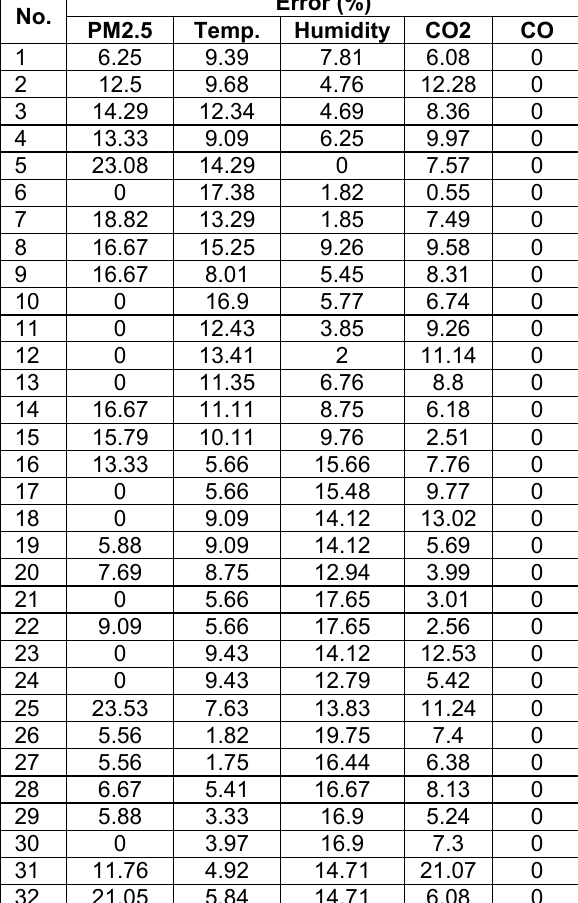
Table 2. Error when comparing our sensoring system to commercial devices